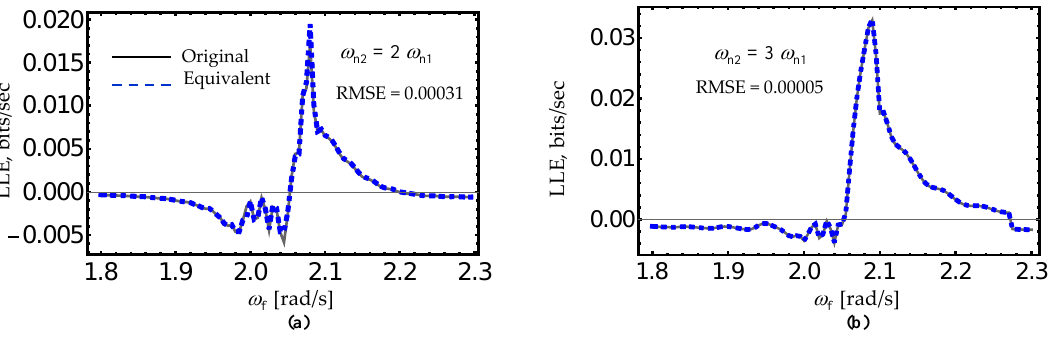
Figure 13. LLE curves computed from the numerical integration solutions of Equations (29) and (43). The parameter values used to obtain these plots were m 1 = 10 kg, m 2 = 0.6 kg, c 1 = 0.1 Ns/m, c 2 = 0.08 Ns/m, k 1 = 44 N/m, k 2 = 8 N/m 3 , k 4 = − 0.65 N/m 3 , and f 0 = 0.37 N; ( a ) LLE vs ω f with k 3 = 9.016 N/m, ( b ) LLE vs ω f with k 3 = 20.828 N/m. Here, the black, solid line represents the LLE computed from the numerical integration solutions of Equation (43), while the blue, dashed line represents the LLE obtained from Equation (29).